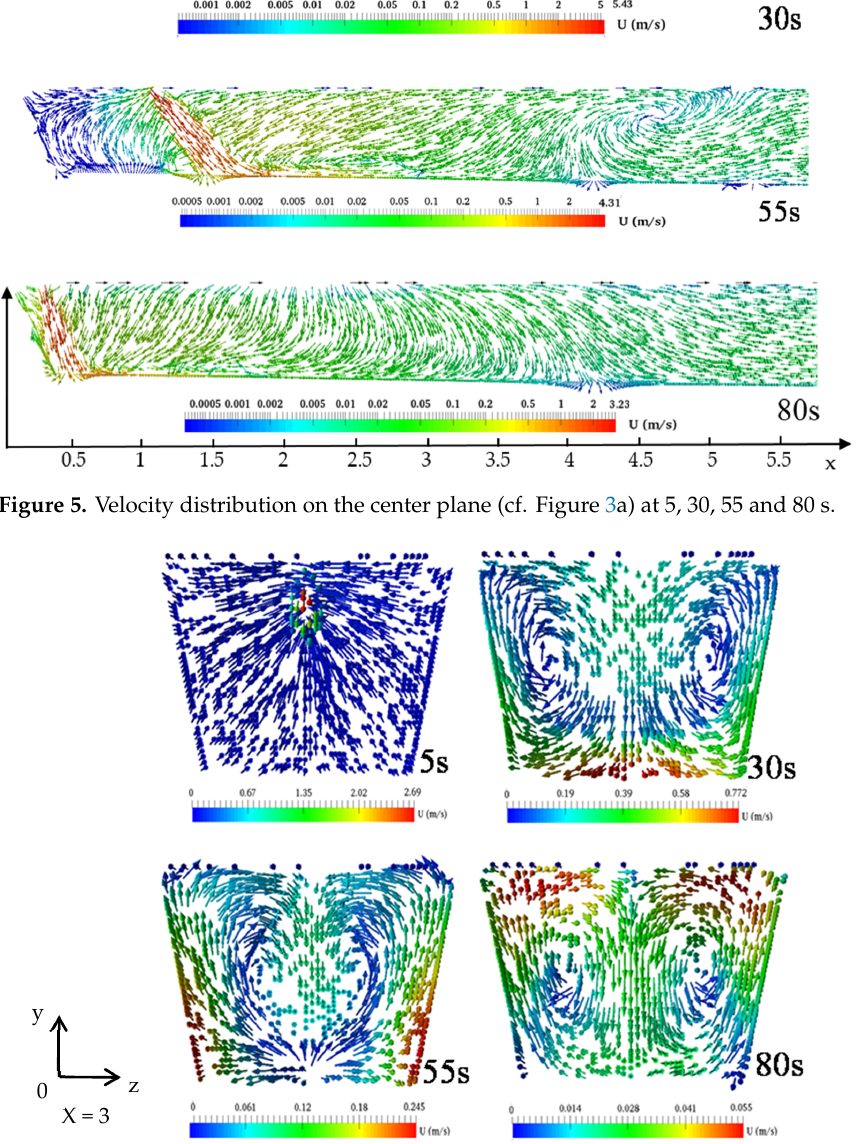
Processes 2020 , 8 , x FOR PEER REVIEW 8 of 13